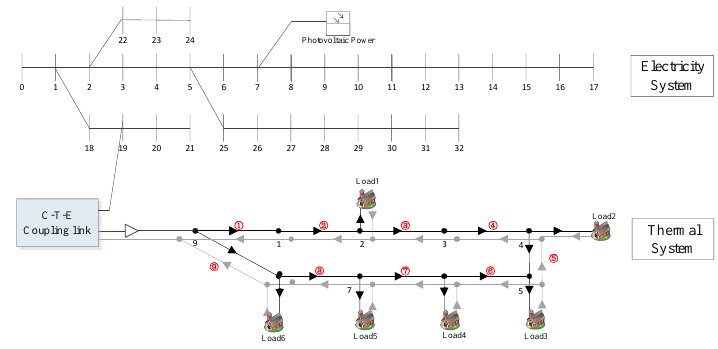
Figure 7. IES containing photovoltaic power generation in bus 7.